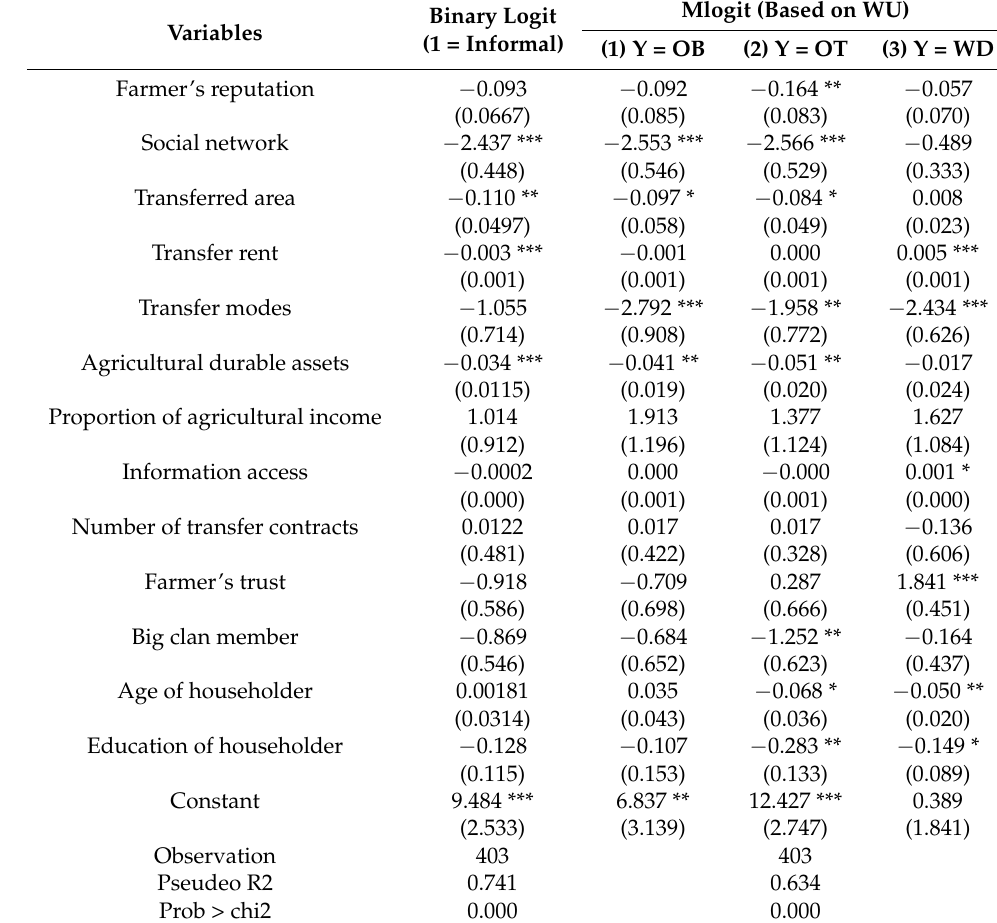
Table 4. The results of contract form choice